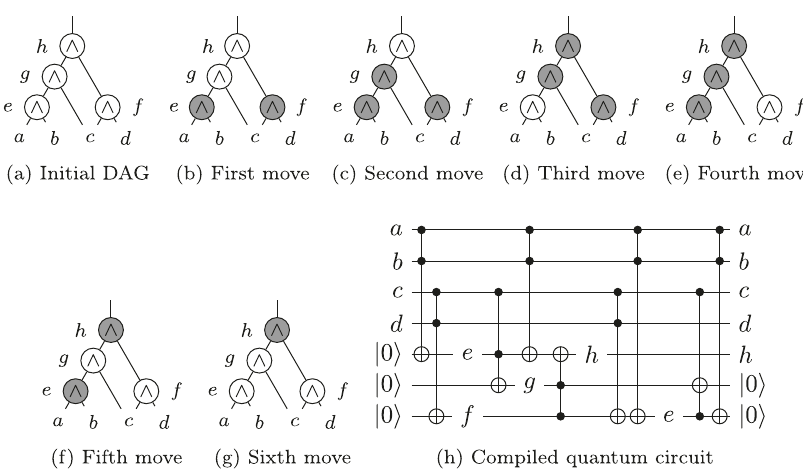
Fig. 7 Illustration of a pebbling strategy using 3 pebbles and 6 moves. a Input DAG; b – g pebbling moves where dark nodes are pebbled; h the corresponding compiled reversible circuit of Toffoli gates.